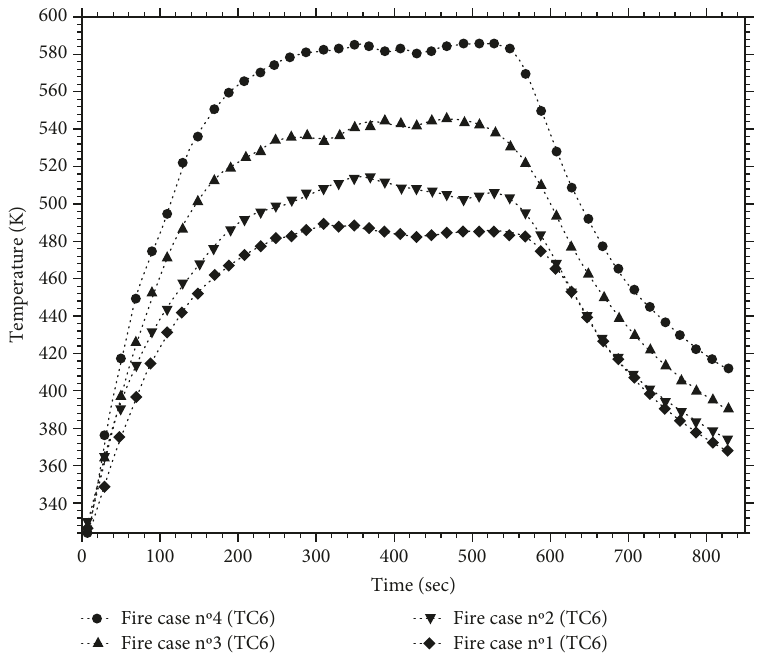
Figure 7: Variation over time of the temperature profiles of hot gases at